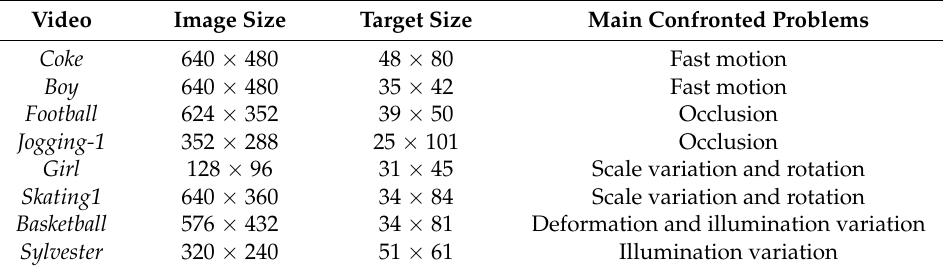
Table 2. Basic information of the eight test